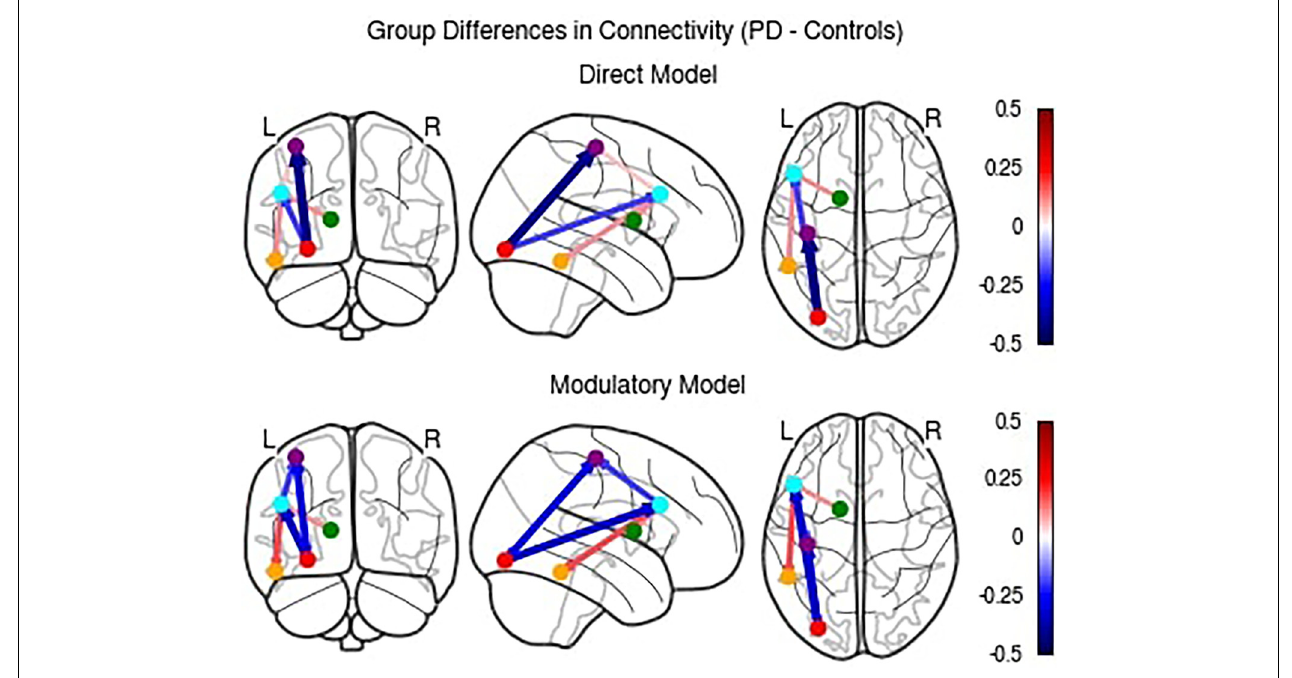
FIGURE 7 | Comparison of differences in direct effective connectivity between PD and Control groups for the Direct and Modulatory Models.